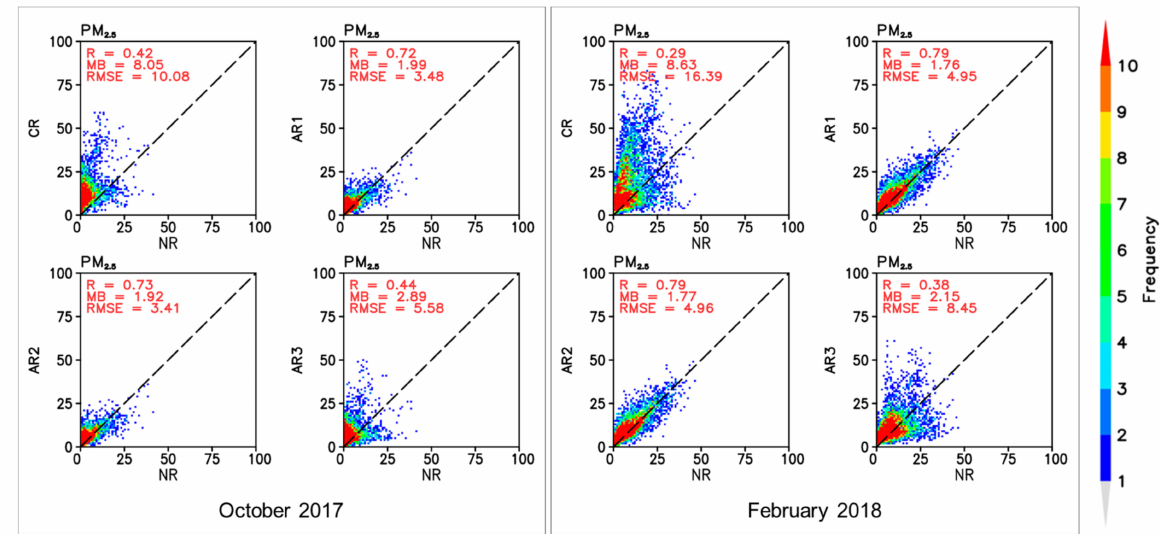
Figure 7. Scatter plots for the AR PM 2.5 mass concentrations (unit: µ g/m 3 ) and the corresponding